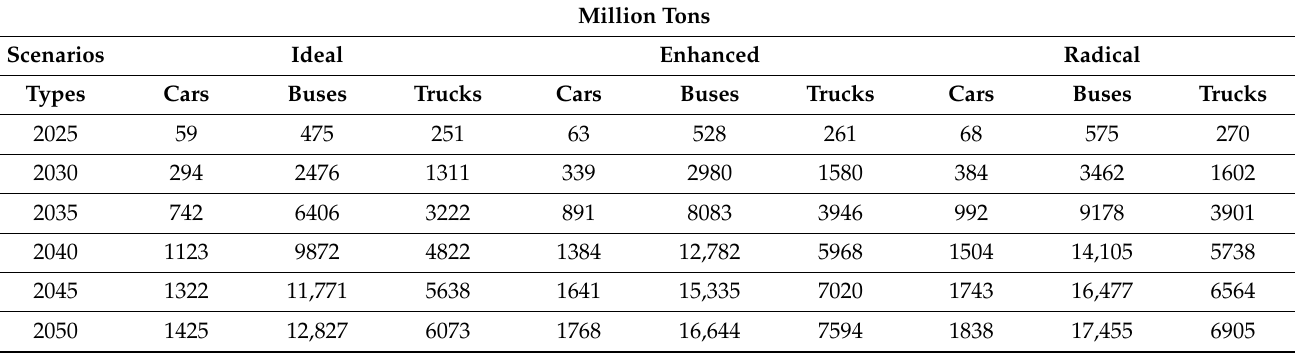
Table 3. Carbon emission reduction potential by different usage types of